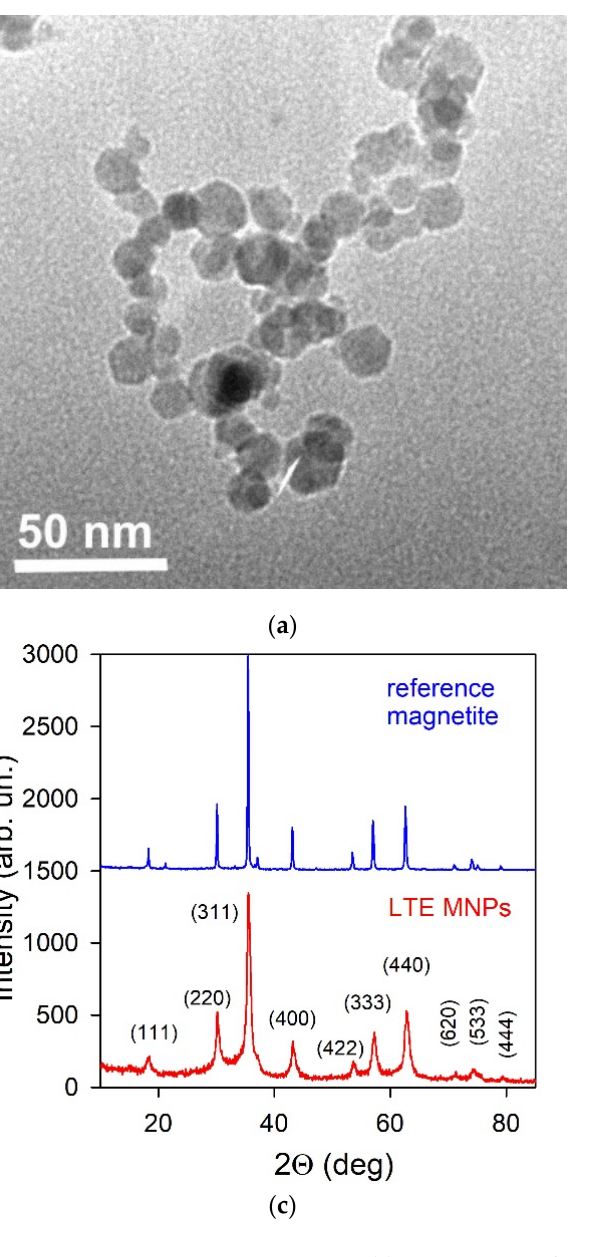
Figure 3. ( a ) Transmission electron microscopy (TEM) image of iron oxide MNPs. ( b ) Particle size distributions, based on the graphical analysis of 2572 TEM images. Histogram filled in dark grey corresponds to the numerical fraction of particles in a certain range of diameters. Blue line is the lognormal fitting of the histogram. Histogram filled in light grey corresponds to the intensity average distribution calculated from TEM images. Dashed red curve is the intensity average PSD measured via dynamic light scattering. ( c ) XRD pattern of iron oxide MNPs with Miller indexes, in comparison with the reference XRD pattern for magnetite (Alfa Aesar, Ward Hill, USA). To avoid overlay, the reference pattern is shifted upward by 1500 arb. Un. ( d ) Hysteresis loop of iron oxide MNPs at 300